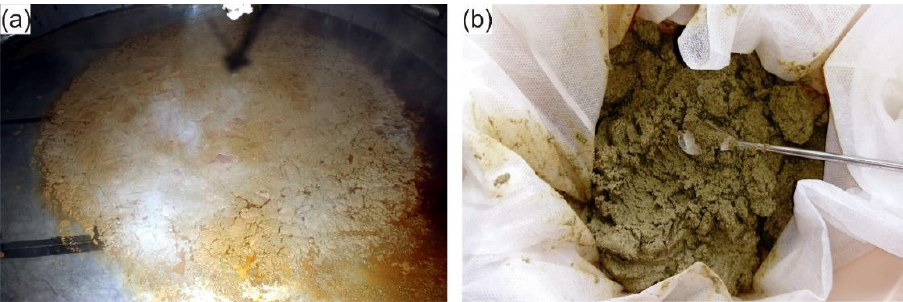
Figure 1. Hot trub ( a ) in the whirlpool tank; ( b ) batch of 70% malted + 30% unmalted barley, water content adjusted to 76%.